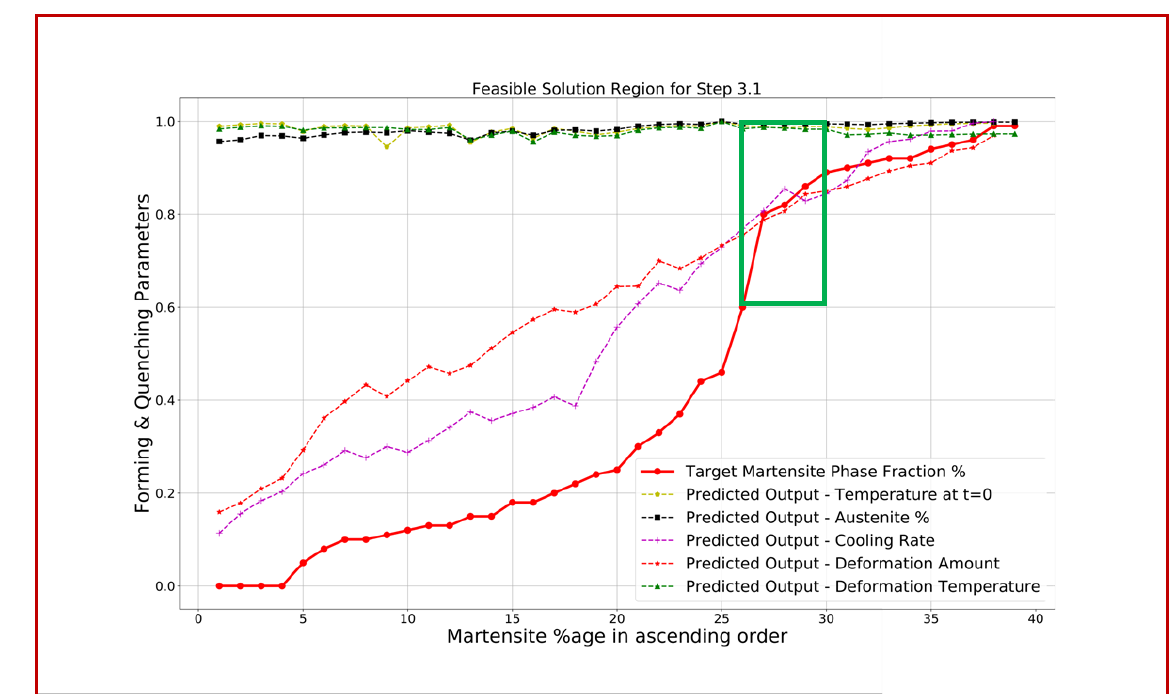
Figure 11. Predicted Output and Actual Output Comparison for Step 3.1 (for Test Dataset).